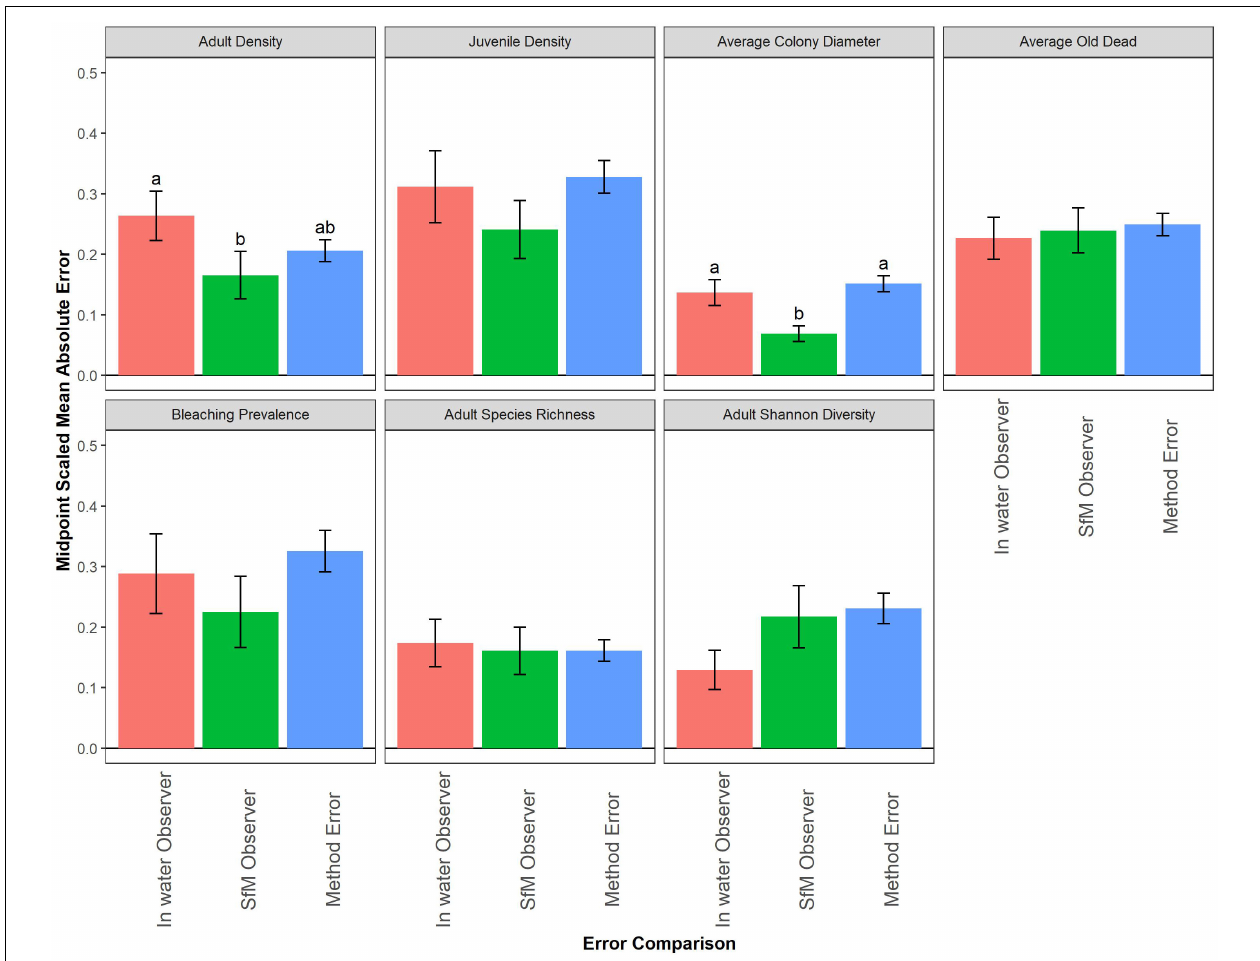
FIGURE 4 | A Comparison of the in-water observer error (difference between divers; red) and structure-from-motion (SfM) observer error (difference between SfM annotators; green) to method error (difference between methods; blue) for each coral demographic metric. Letters , when present, denote significant differences among error types based on post hoc tests for each metric using Dunn’s tests with Benjamini and Hochberg multiple test corrections (adjusted α = 0.05).